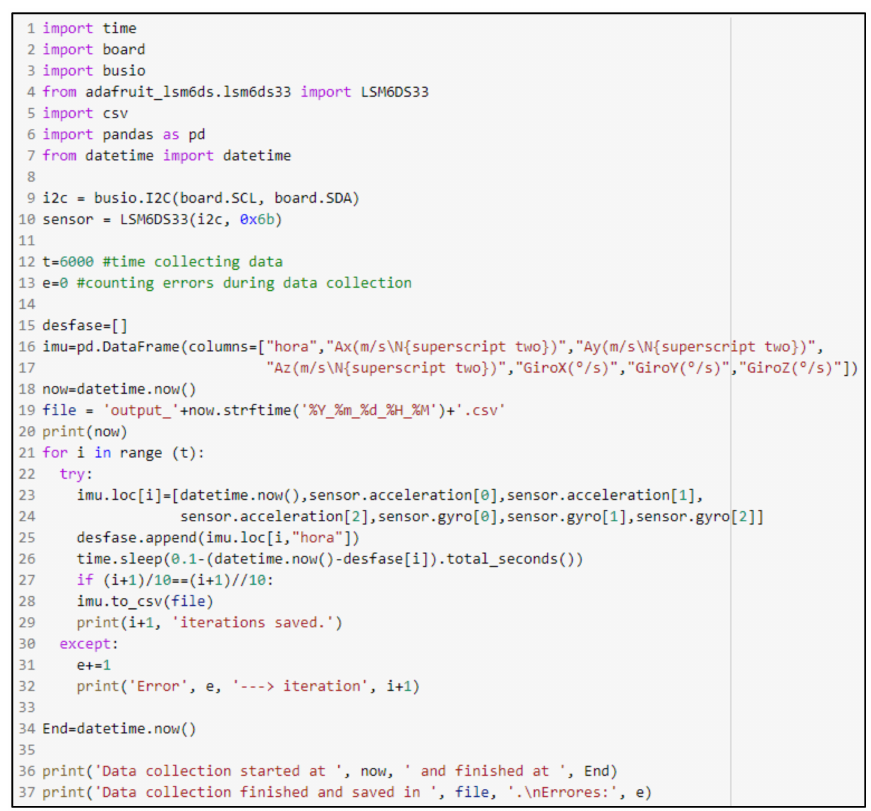
Figure 4. Script programmed in Python for the use of MinIMU-9